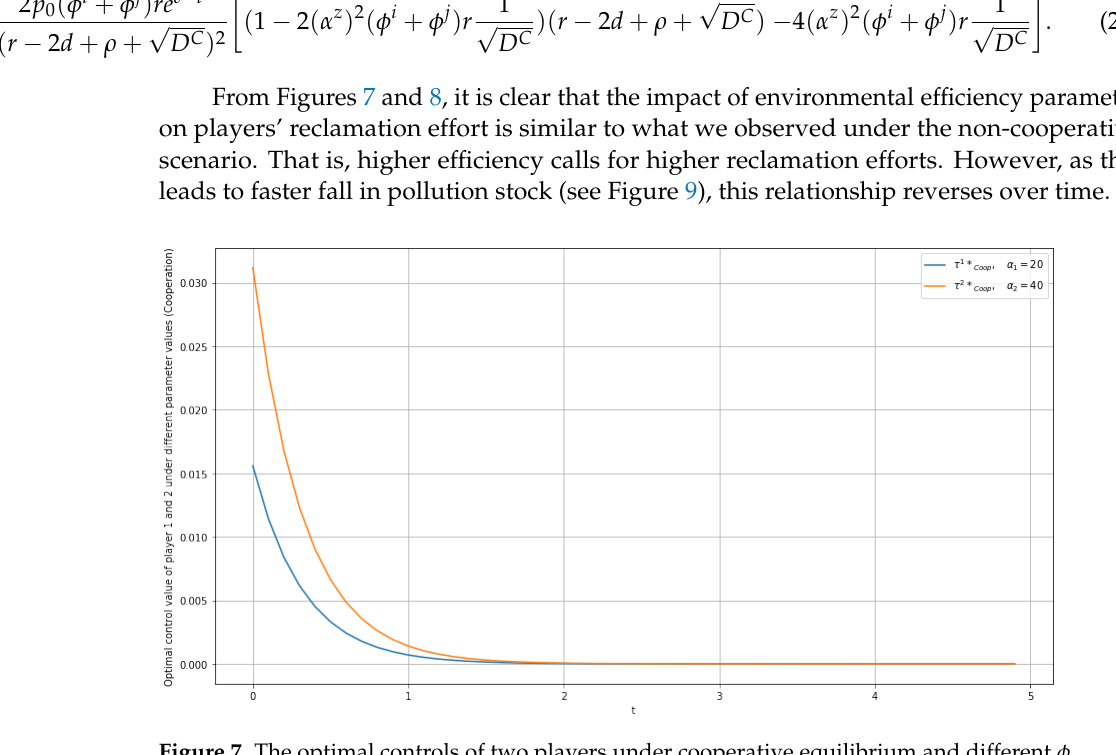
Figure 7. The optimal controls of two players under cooperative equilibrium and different φ